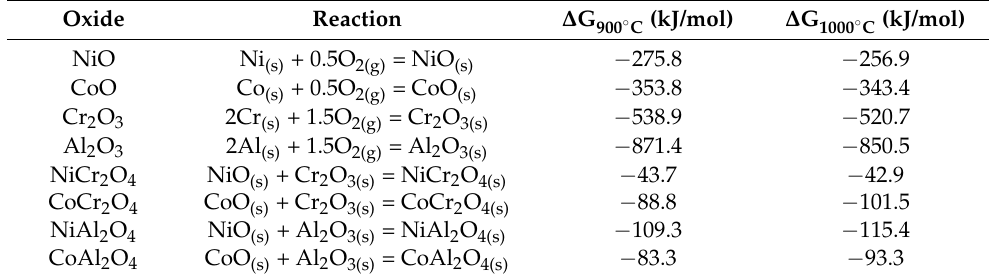
Table 5. Probable oxides and their oxidation reactions with the corresponding Gibbs free energy of formation